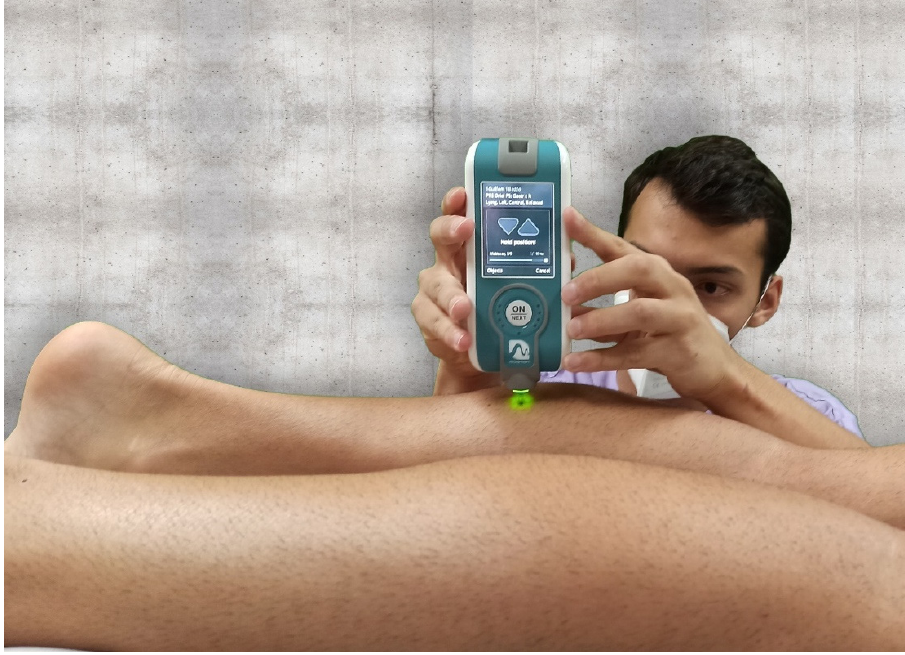
Figure 1. Viscoelastic properties of gastrocnemius muscles were assessed by